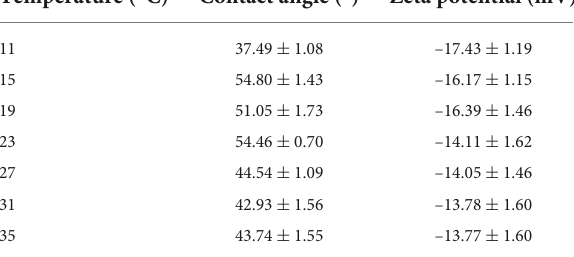
TABLE 2 Changes of water contact angle and zeta potential under different